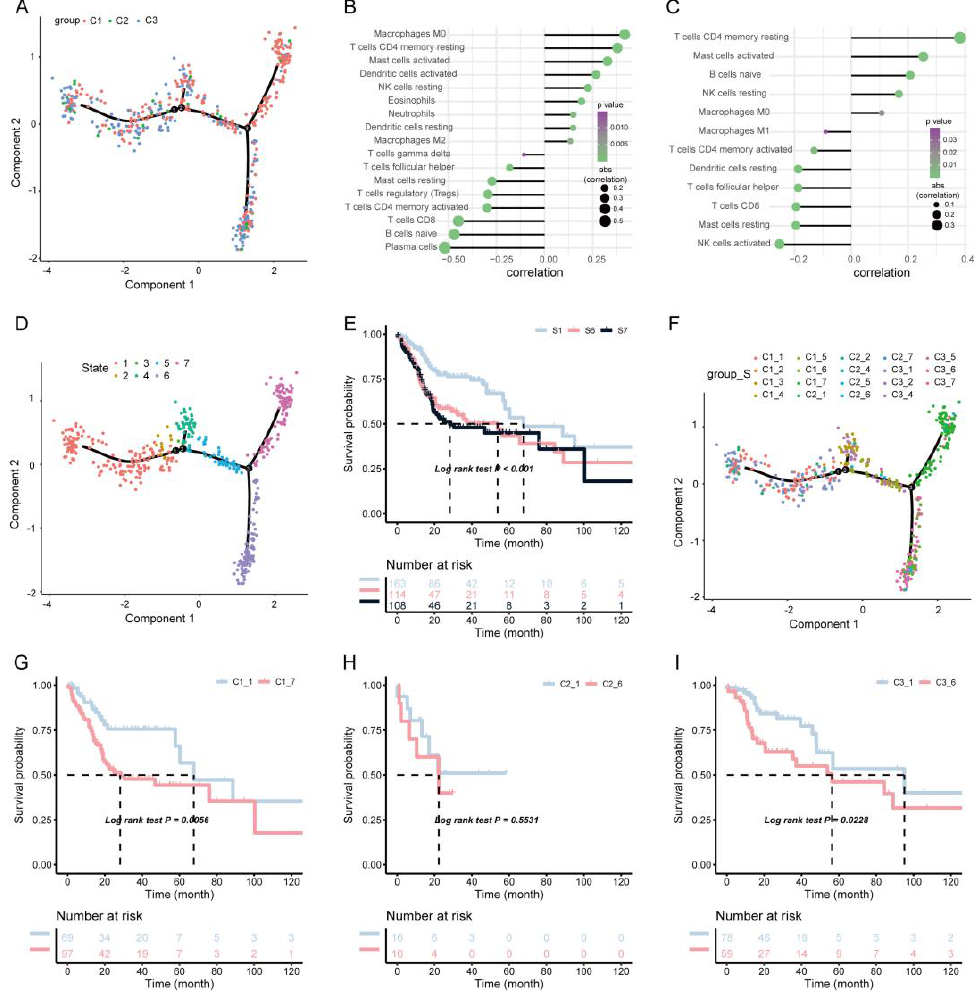
Figure 7. The immune landscape of HNSC. ( A ) The immune landscape of HNSC. Each point represents a patient, and the immune subtypes are color-coded. The horizontal axis represents the first principal component, and the vertical axis represents the second principal component. ( B ) Correlation between PCA1 and immune infiltration. ( C ) Correlation between PCA2 and immune infiltration. ( D ) Patients were separated by the immune landscape based on their location; ( E ) separated patients were associated with different prognoses. ( F ) C1, C2, and C3 are further stratified according